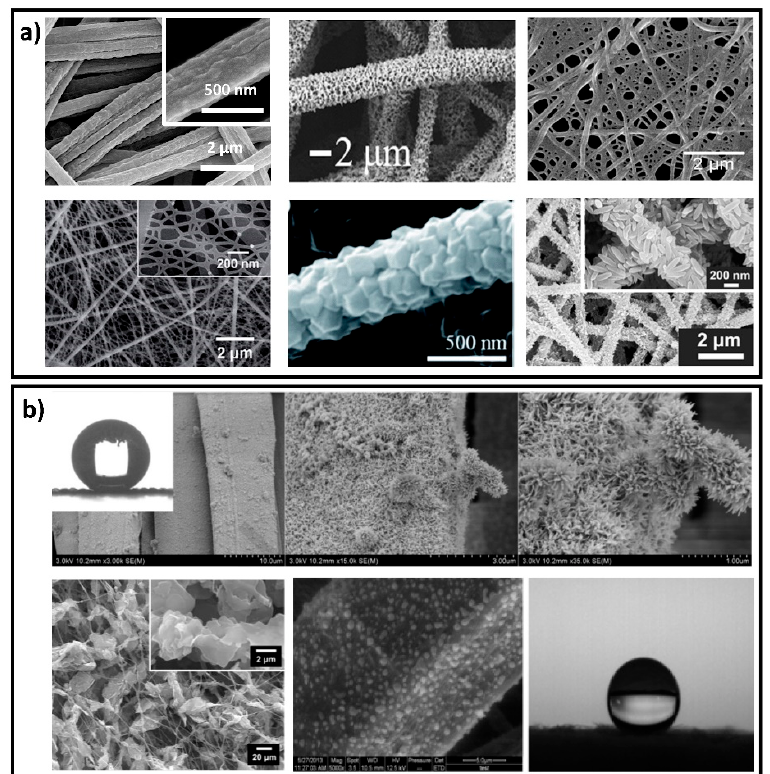
Figure 7. ( a ) Scanning electron microscope images of fibrous materials containing novel secondary nanostructures. Reprinted with permission from [377] © 2019, Wiley; [378] © 2019, American